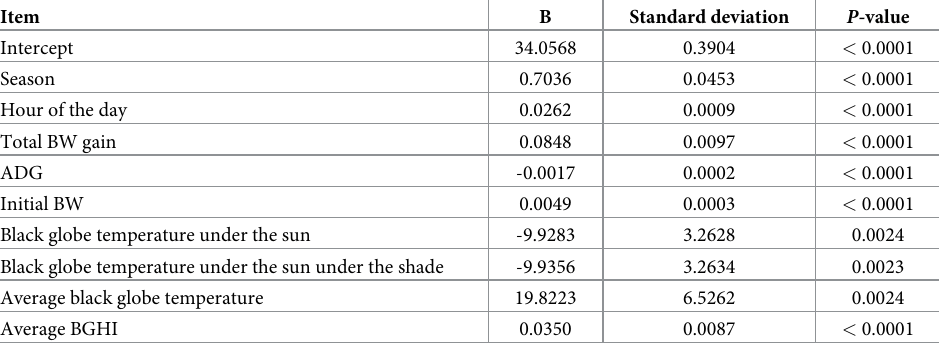
Table 3. Partial regression coefficients and their respective standard deviations of a linear function for the vaginal temperature of Nellore heifers in systems with different microclimatic conditions.